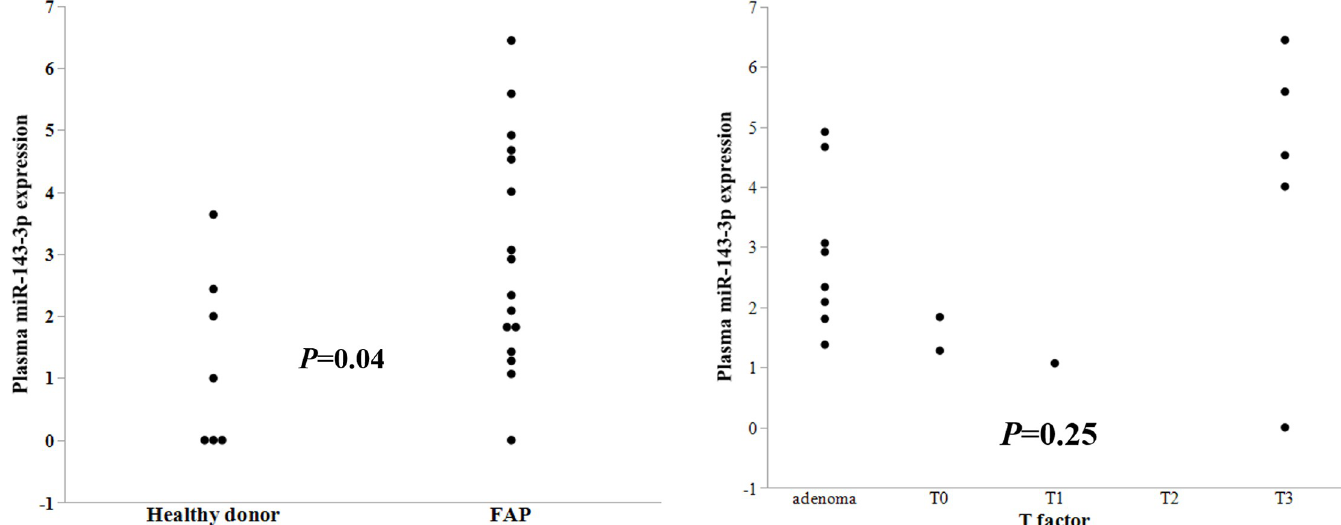
Fig 2. A. Plasma miR-143-3p expression levels in patients with familial adenomatous polyposis (FAP) and healthy donors (Control). There was a significant difference in miR-143-3p expression between the two groups ( P = 0.04). B. Plasma miR-143-3p expression levels in patients with familial adenomatous polyposis (FAP) by T factor. There is no significant difference in miR-143-3p expression by T